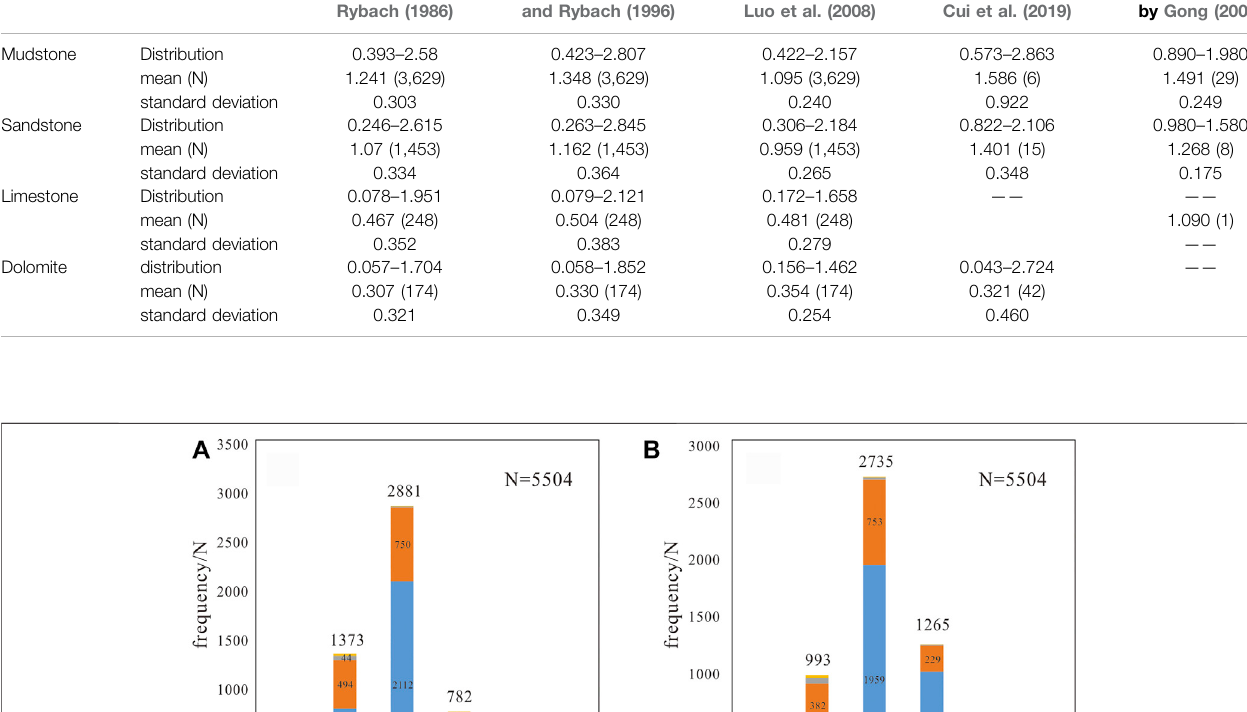
TABLE 1 | Comparison and statistics of calculated radioactive heat production of different lithologies using different empirical relationships and measured heat production. Lithology